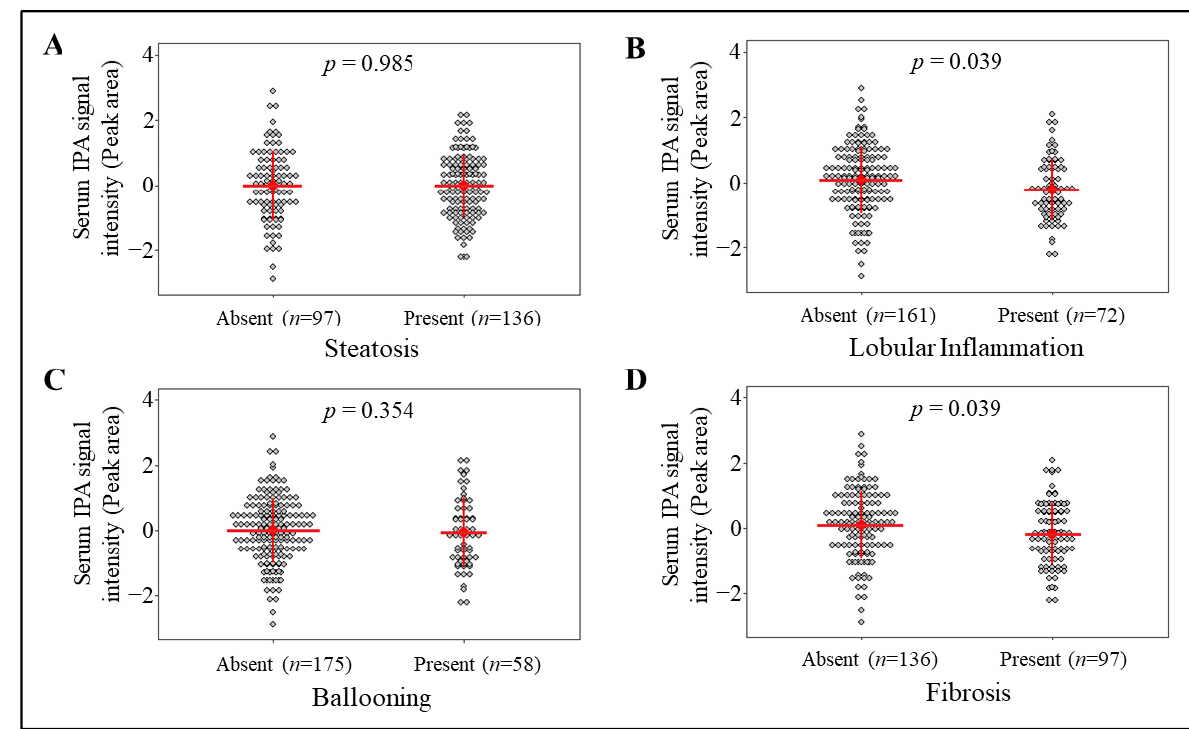
Figure 1. Associations of serum IPA signal intensity with liver histology, based on presence (all except 0) or absence (stage/grade 0) of each specific histological characteristic. Dot plot presents the inverse-normalized serum IPA signal intensities ( y -axis) across the ( A ) steatosis, ( B ) lobular inflammation, ( C ) ballooning and ( D ) fibrosis. Red lines and whiskers represent mean serum IPA signal intensity and SD, respectively. The number of individuals in each group are indicated for each group in parentheses. General linear model (univariate) test results p value is shown as p for each comparison between presence or absence of each specific histological characteristic.